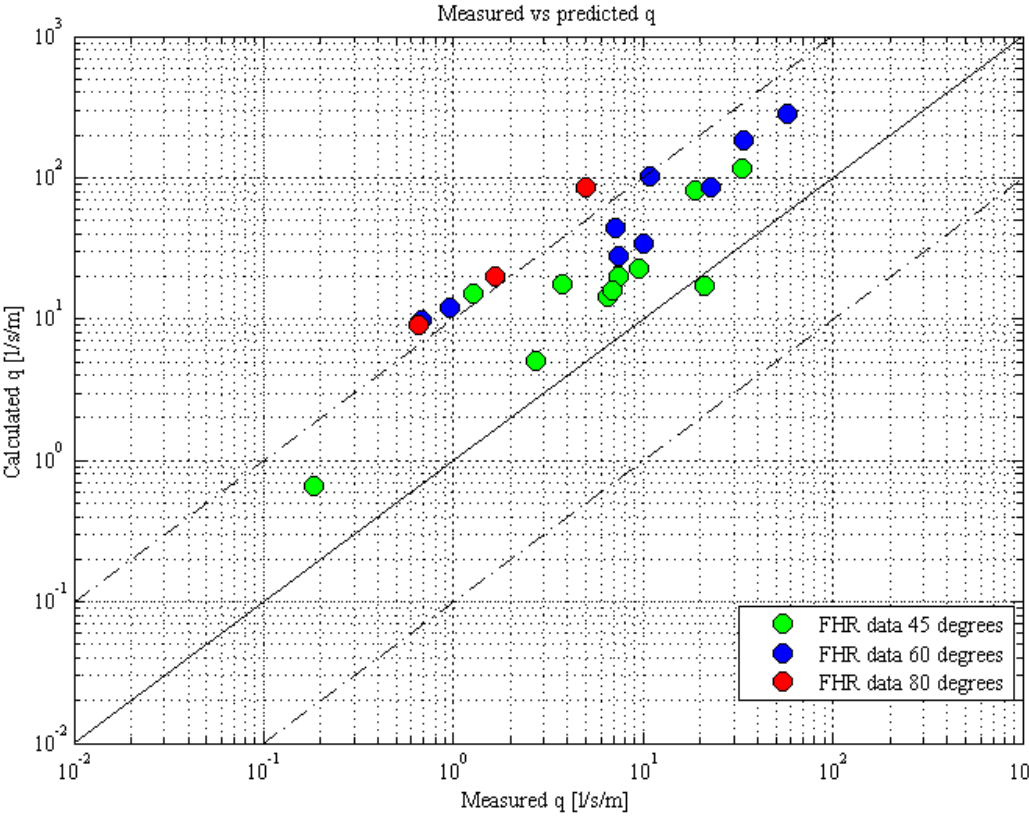
Figure 13. Sloping dike: predicted (EurOtop, 2007) vs. measured overtopping discharges.